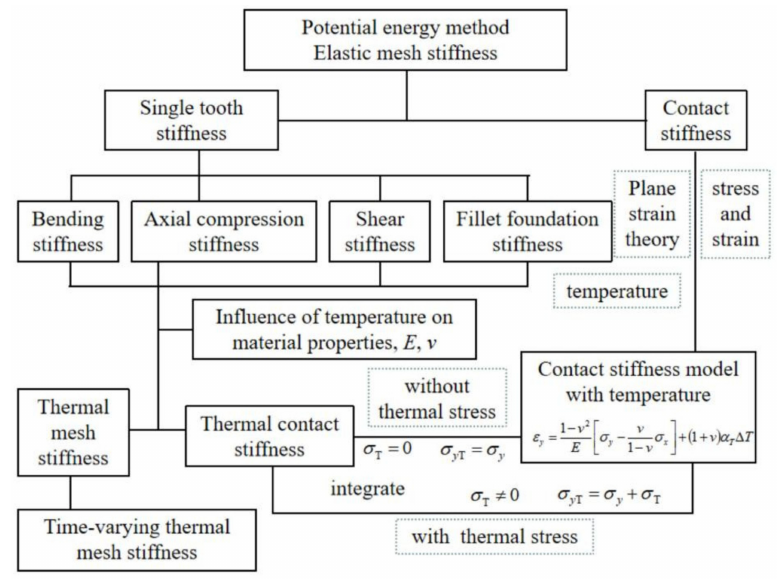
Figure 1. The flow chart to summarize the proposed